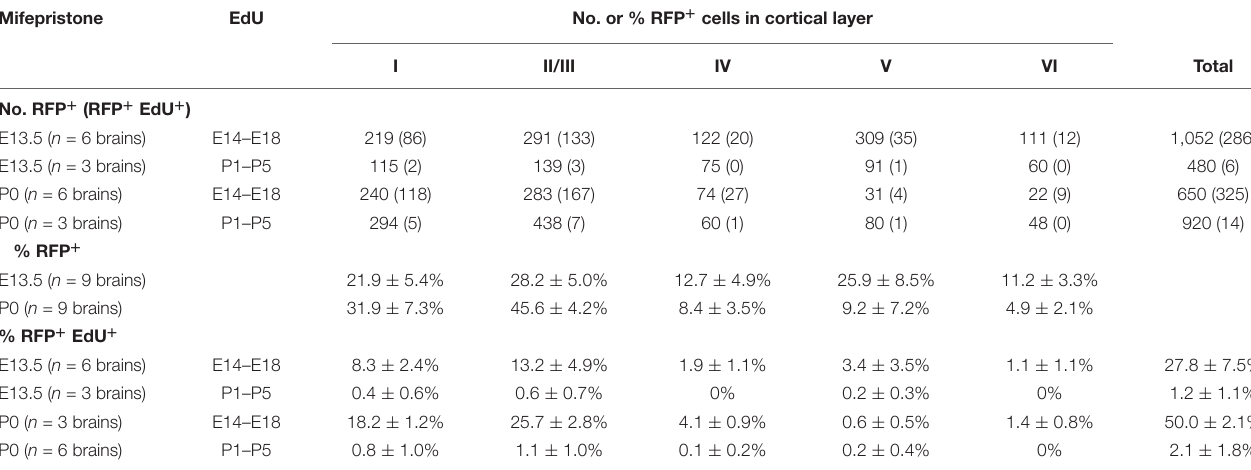
TABLE 2 | Localization of GAD67-lineage and EdU + cells in 3 weeks mice treated with mifepristone at P0 and E13.5.